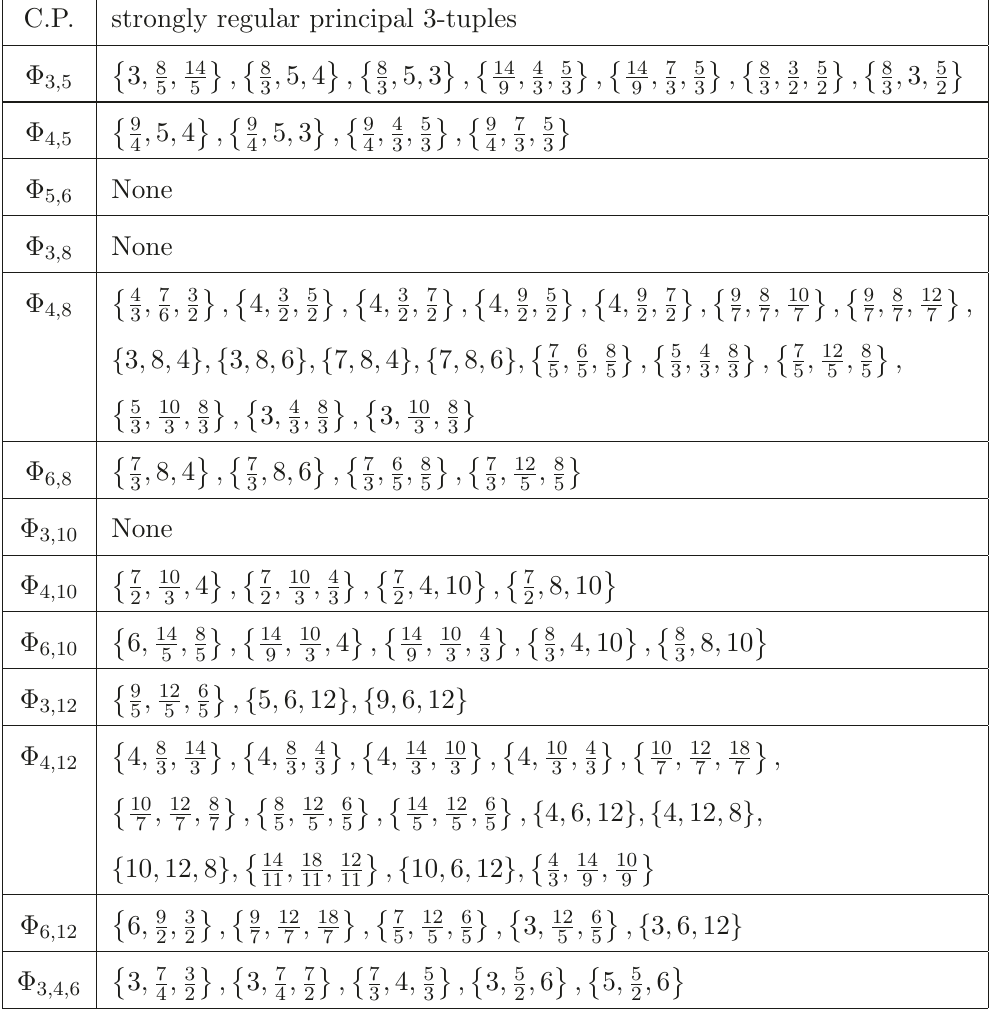
Table 9 . Strongly regular principal 3-tuples for rank